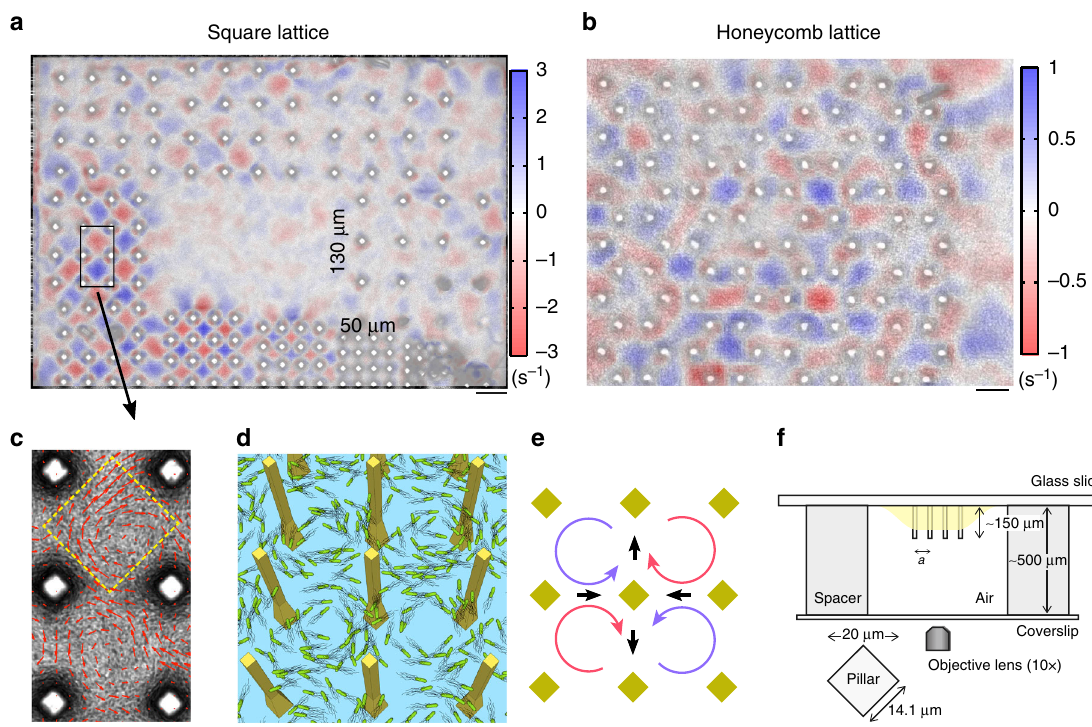
Fig. 1 Self-organized bacterial vortex lattices. a A snapshot of bacteria swimming between square latices of pillars overlaid with a color plot of the average vorticity magnitude 〈 rot v ( r , t ) 〉 t . Pillars are arranged in nine arrays with different lattice constant a increasing from 50 μ m to 130 μ m (clockwise) in 10 μ m increment. The 40- μ m lattice is excluded from analysis due to damaged pillars. Scale bar: 100 μ m. b Distribution of the average vorticity magnitude for a honeycomb lattice. Scale bar: 50 μ m. c Close-up of the rectangular area shown in a . Arrows indicate instantaneous velocities. Yellow dashed line depicts a single ROI area. Scale bar: 50 μ m. d An artistic representation of bacteria swimming between 3D-printed micropillars (yellow). e Swimming bacteria self- organized in a lattice of vortices with antiferromagnetic order due to hydrodynamic interaction between adjacent vortices. Black arrows indicate the direction of bacterial fl ow between vortices. f A schematics of the experimental setup. For clarity, only one set of pillars is